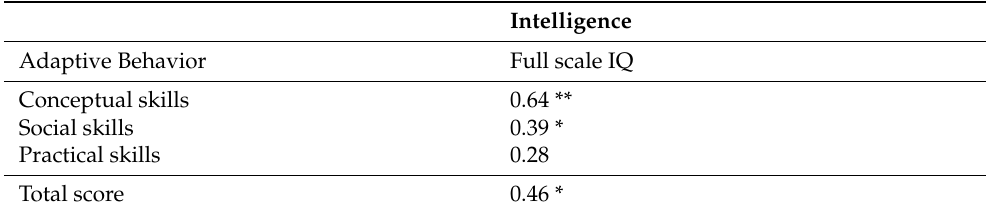
Table 2. Correlation coefficients between intelligence and adaptive